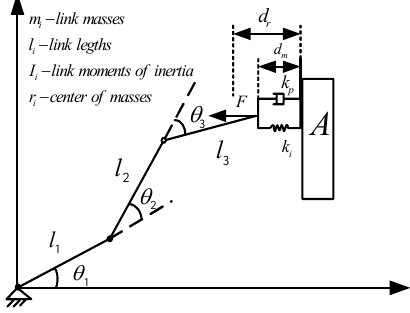
Fig. 1 Planar 3 RRR underactuated manipulator When the obstacle detection system does not detect intrusion into any dangerous zones ( , the user- m r specified nominal path is executed and the arm performs an obstacle-free motion. As soon as any point on the arm enters the dangerous zone which is determined by the obstacle detection